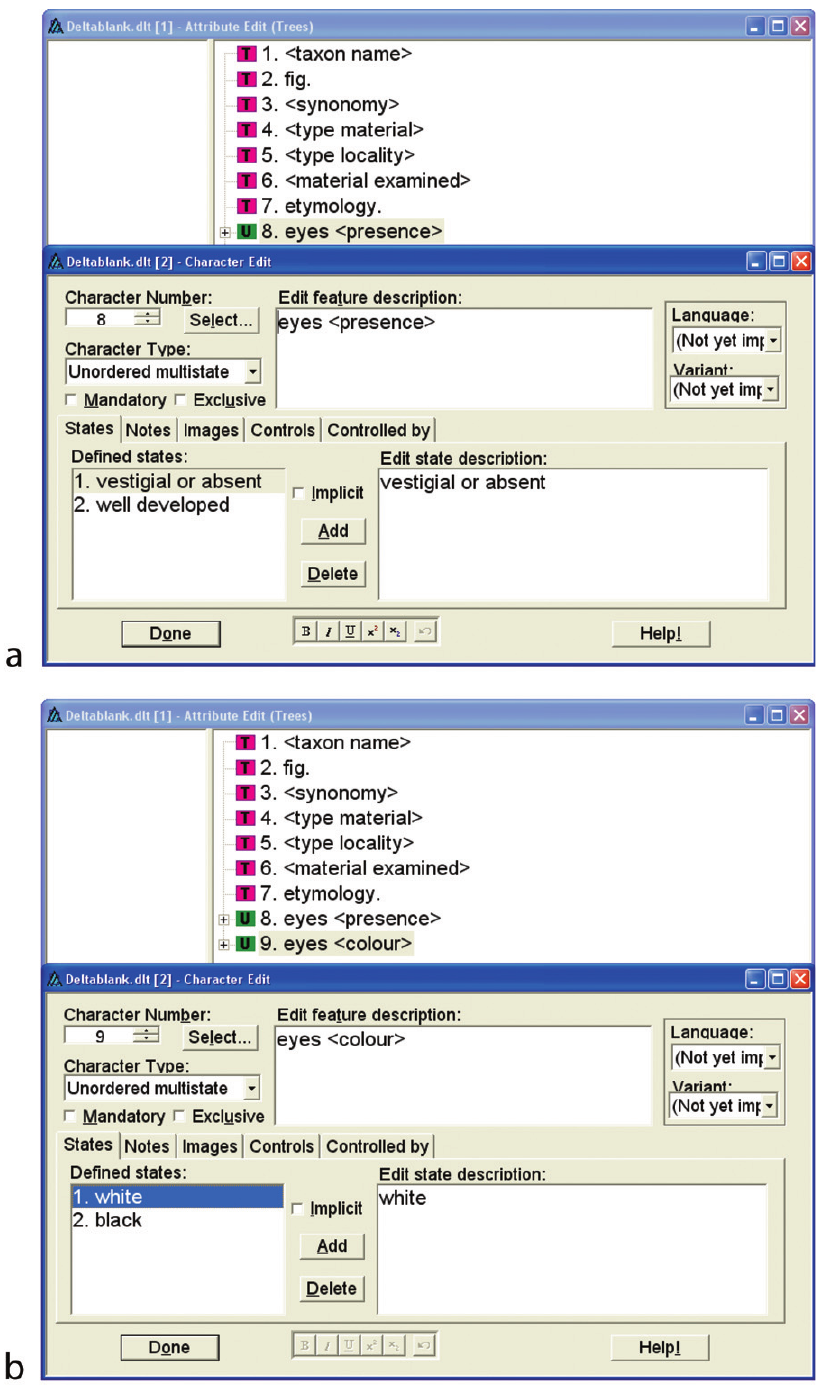
Figure 7a–b. Defi nition of two Unordered multistate characters